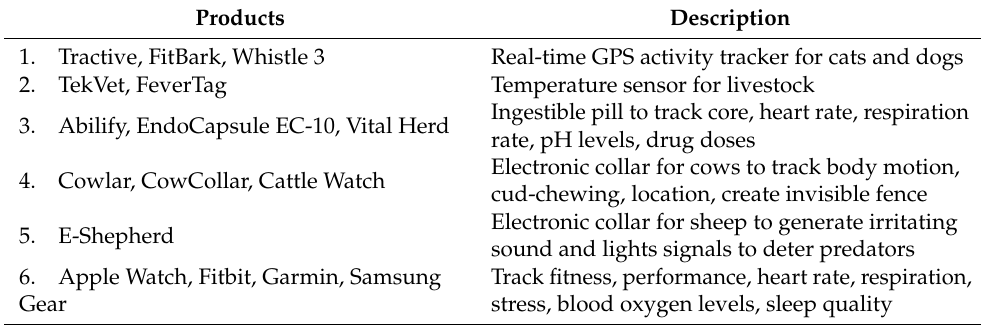
Table 1. Commercialized products for tracking humans, pets, and